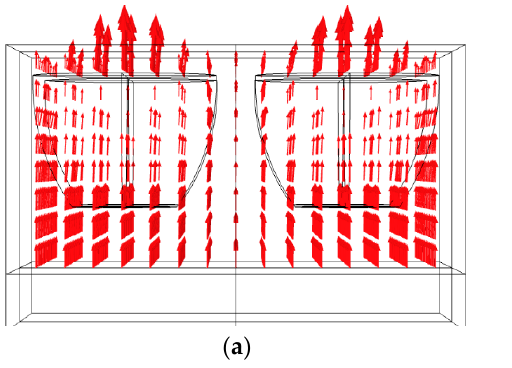
Figure 15. Vibrational velocity diagram at the maximum absorption coefficient, ( a ) Unit ‐ cell model 1, 1000 Hz; ( b ) Unit ‐ cell model 2, 1900 Hz. 1000 Hz; ( b ) Unit-cell model 2, 1900